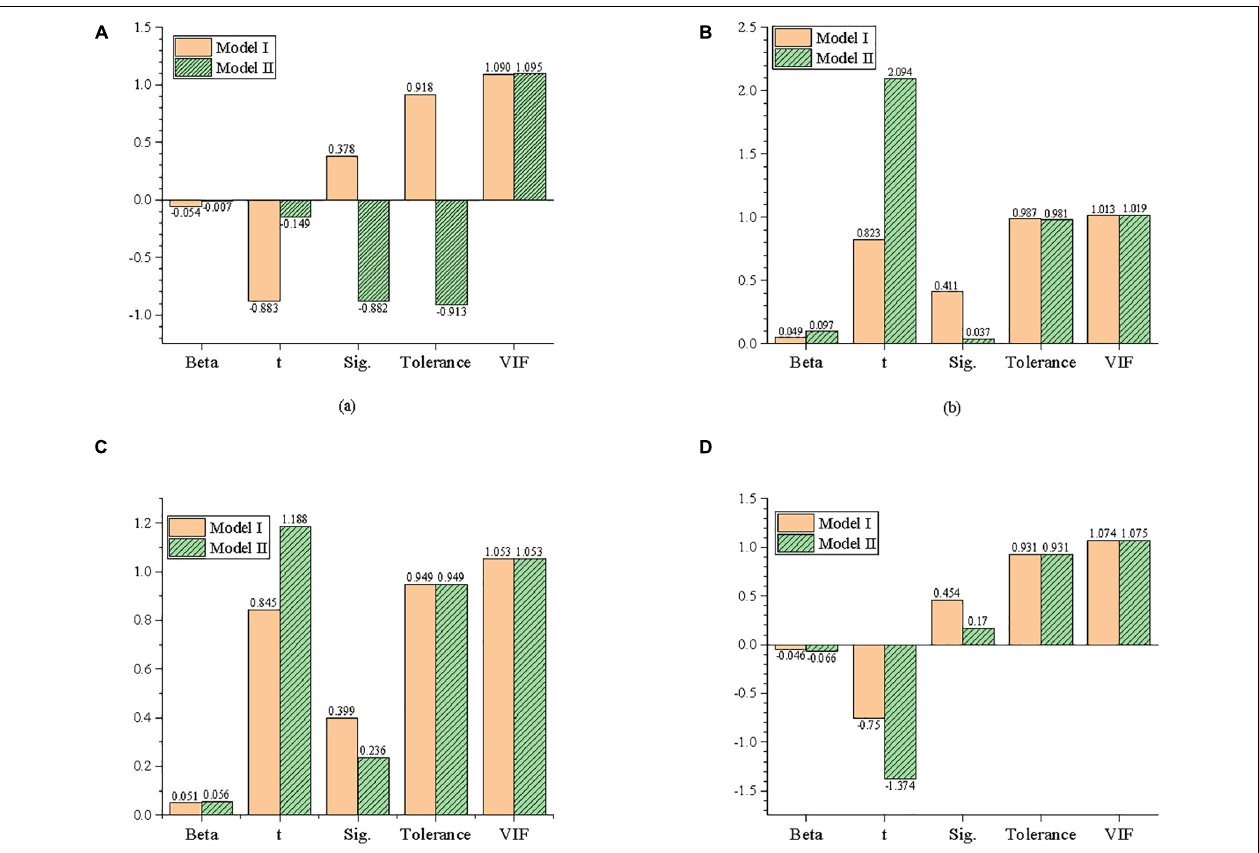
FIGURE 8 | Regression analysis of the effect of model innovation on entrepreneurial behavior. (A) Educational background, (B) gender, (C) age, and (D) company